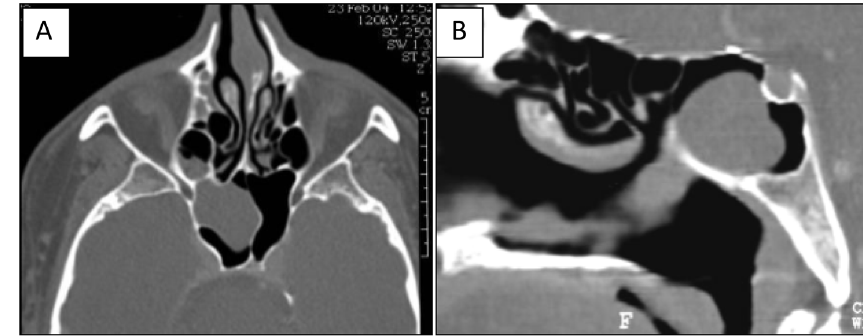
Fig. 4 Case 4. Spheno-choanal polyp. CT scan axial view ( A left) showing a right sphenoid sinus mass with posterior ethmoidal cell’s retention. Sagittal view ( B right) showing a sphenoid sinus’s well-defined mass expanded to the rhinopharynx suggesting a spheno-choanal